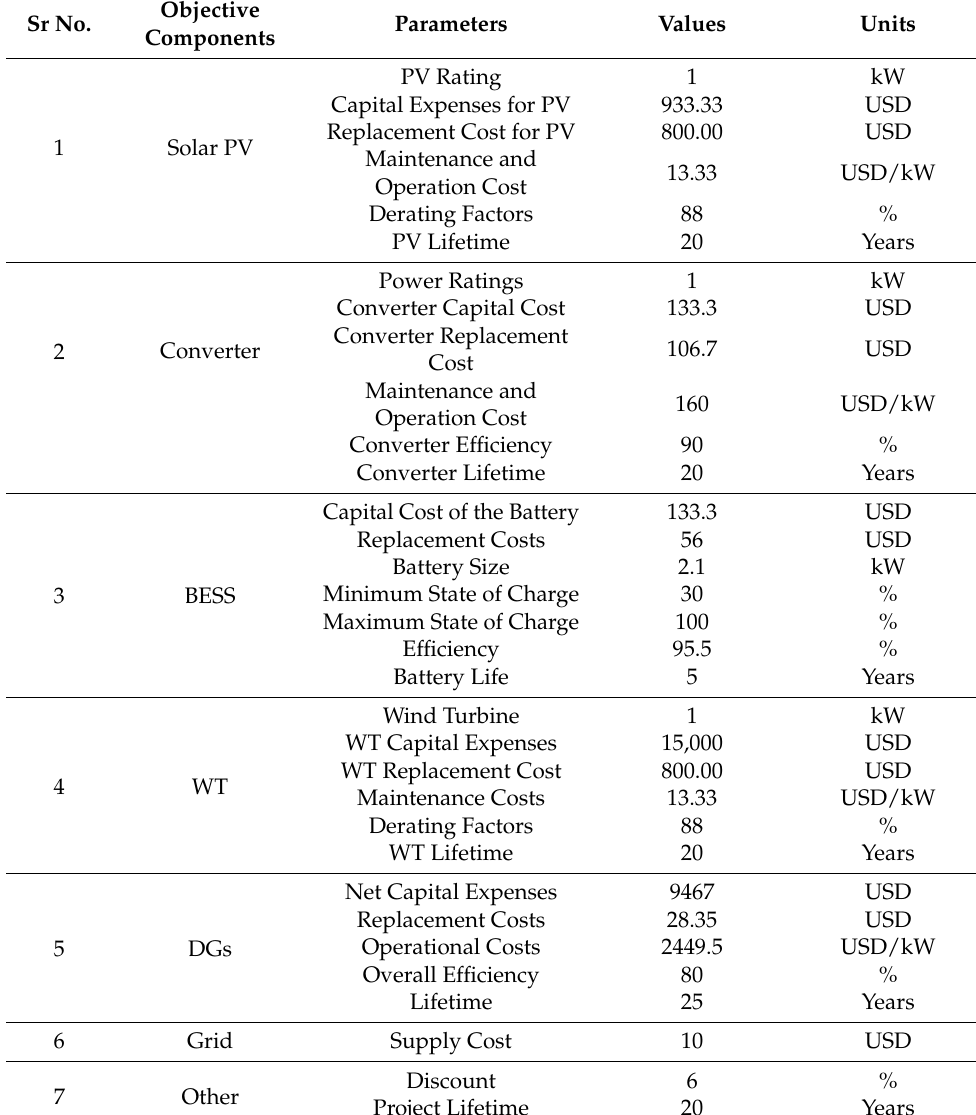
Table 7. Techno-economic price comparison of different types of components connected with the proposed